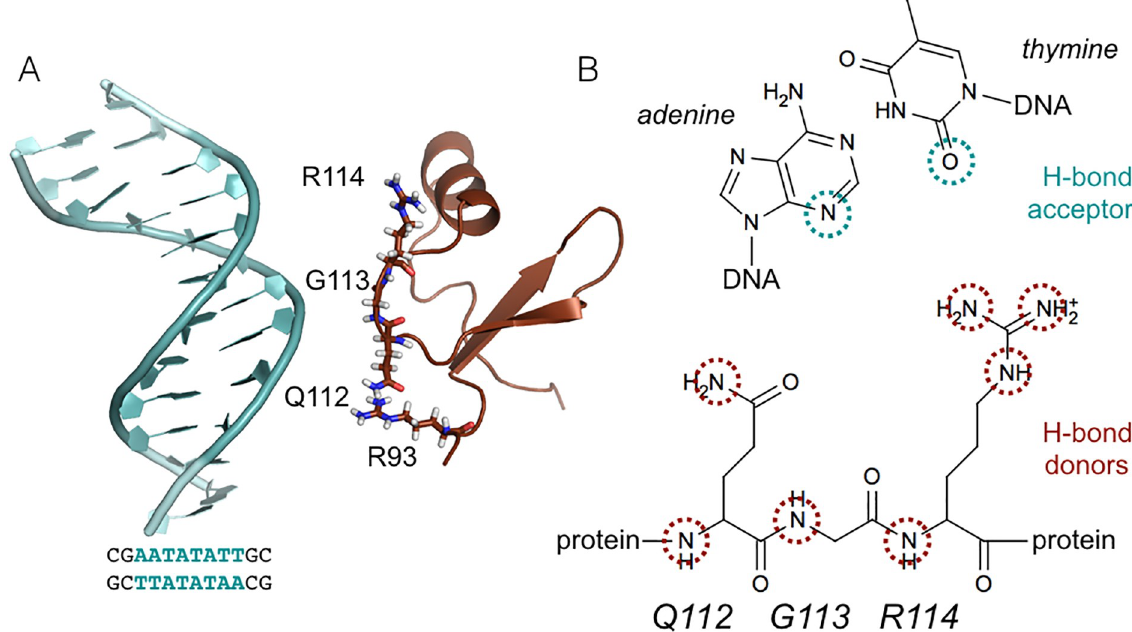
Fig 1. System details. (A) Snapshot of the initial unbound configuration. The protein (brown) and DNA (light blue) are shown in cartoon representation. The QGR motif (residues 112-114) and R93 are shown as sticks. (B) Scheme indicating the hydrogen bond partners involved in the binding of H-NS to DNA. The donors are provided by the QGR motif in H-NS, highlighted by brown circles. The acceptors are located on the bases at the minor groove side of the DNA, indicated by blue